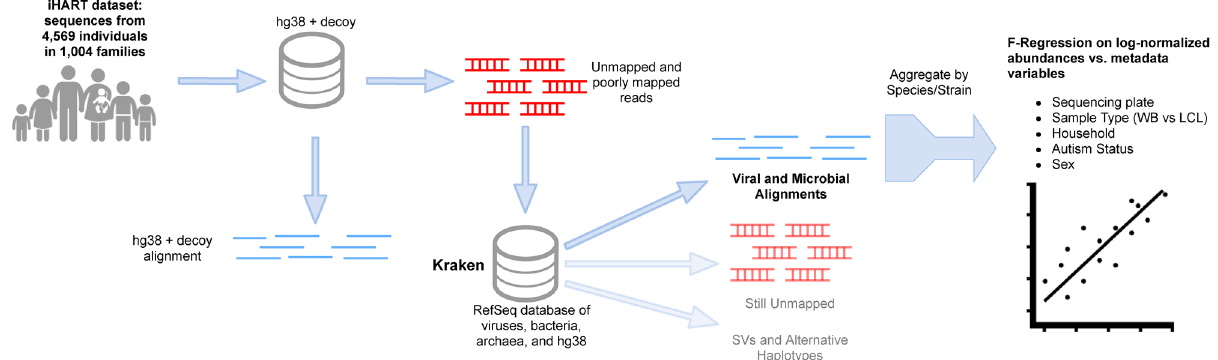
Figure 1. The general pipeline of the study: Reads from the iHART dataset that were unmapped or poorly aligned to GRCh38 were extracted and reclassified to a database of viruses, bacteria, archaea using Kraken. An F-regression was then performed on bacterial and viral counts against various sample-level